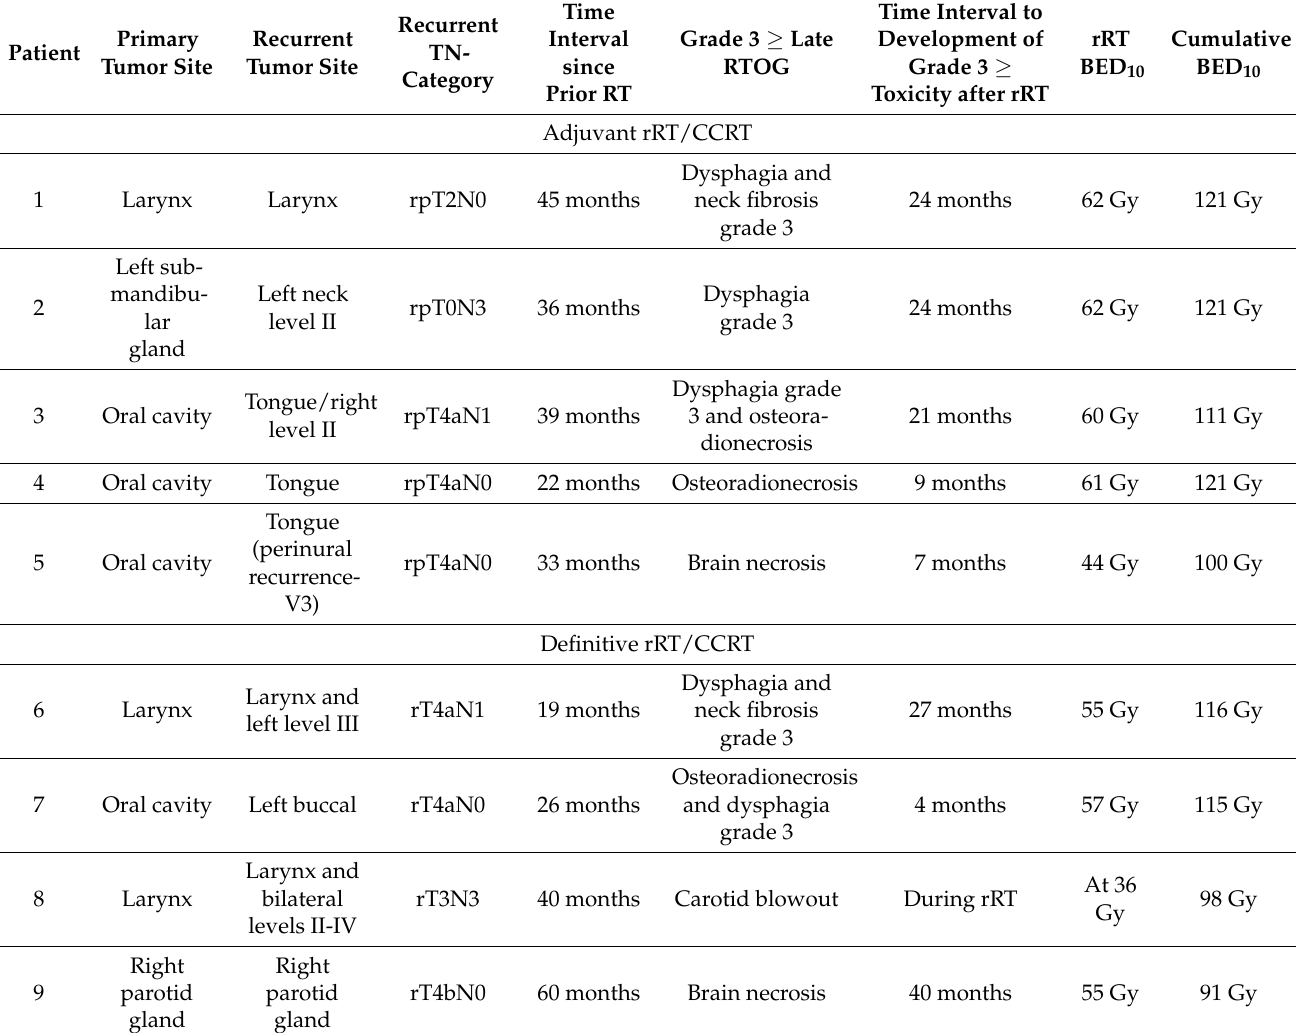
Table 3. The primary tumor site, recurrent tumor site, recurrent rTN-category, time interval